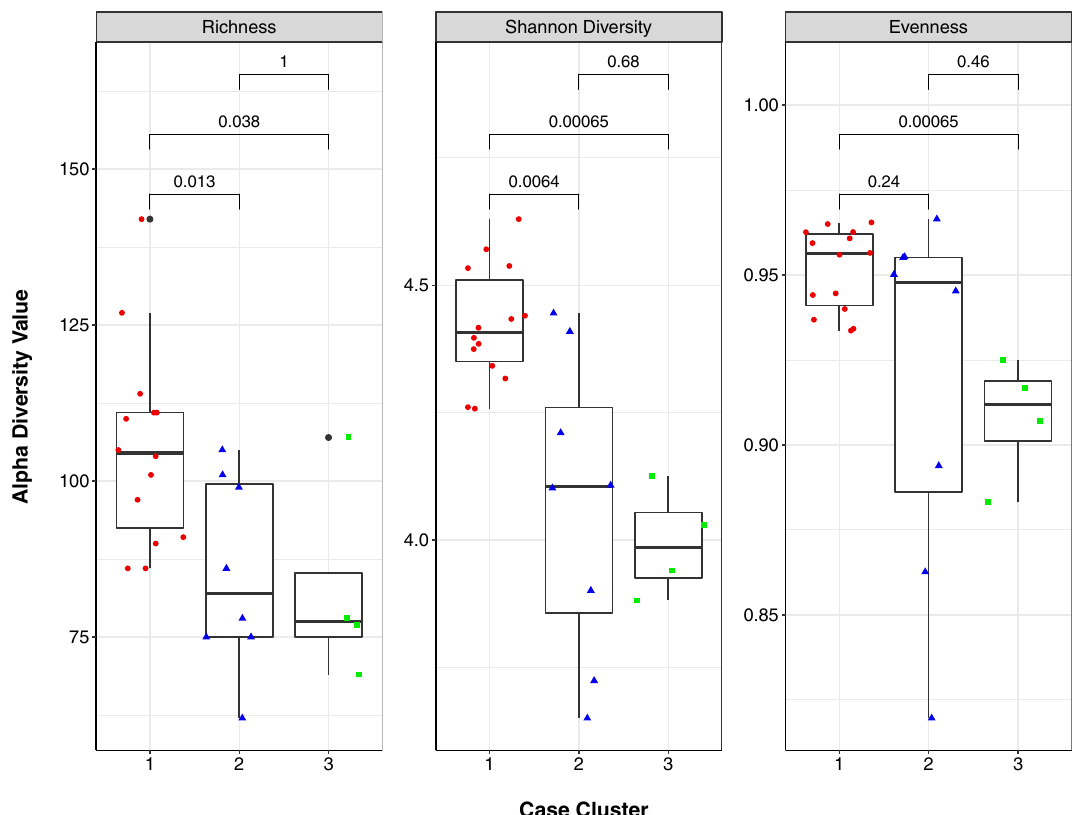
Figure 6. Case Cluster 1 resistomes are more diverse than resistomes of Clusters 2 and 3 combined . Boxplots displaying alpha diversity metrics for resistomes representing case Cluster 1 (red circles), Cluster 2 (blue triangles) and Cluster 3 (green squares) are shown. Resistome richness, diversity (Shannon), and evenness are indicated. The median of each measure is shown by the black bar within each box and the first and third quartiles are indicated by the bottom and top of the box, respectively; points show variation within sample types. P-values were calculated using the Wilcoxon rank-sum test and are shown above the comparison bar within each plot.